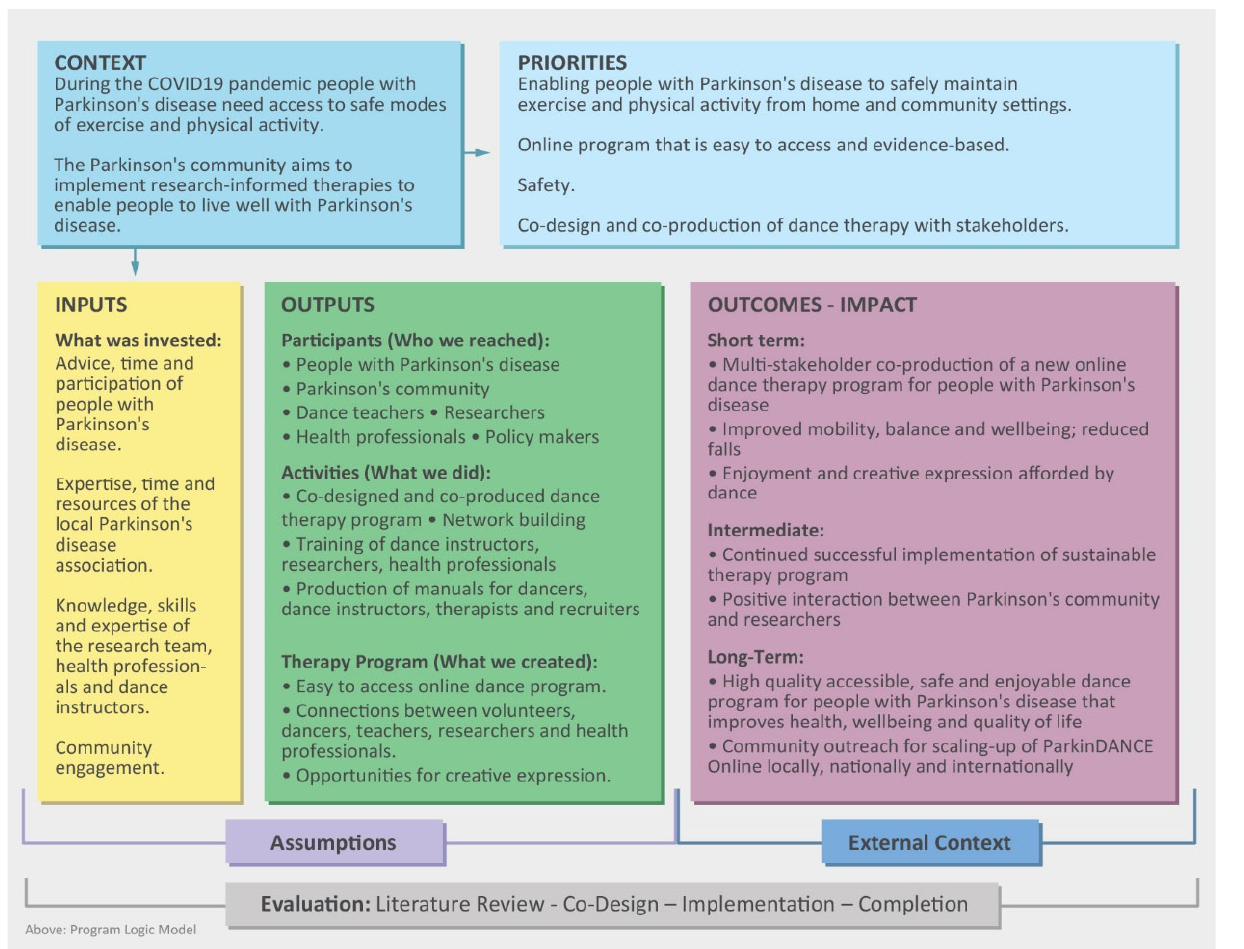
Figure 1. Key Inputs, Outputs, and Context Supporting Program Logic Model.